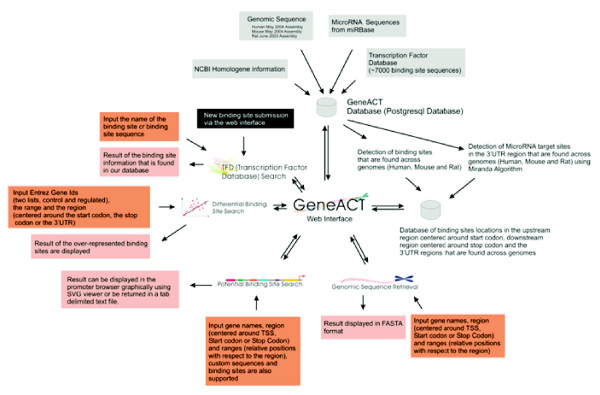
Overview of the GeneACT architecture and method.